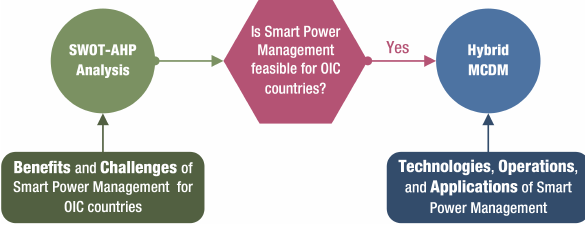
Figure 4. The overall process of the critical analysis.